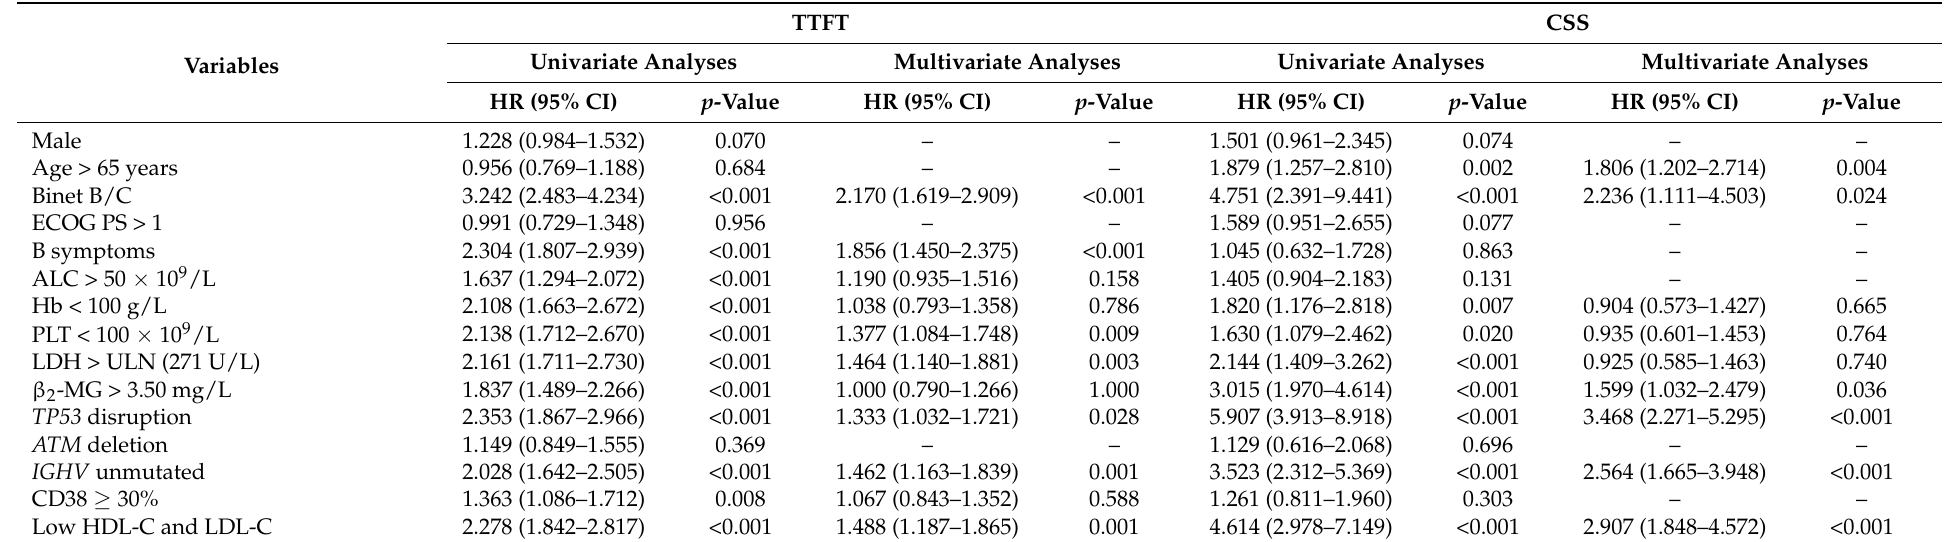
Table 2. Univariate and multivariate analyses of TTFT and CSS in the derivation cohort. TTFT CSS Univariate Analyses Multivariate Analyses Univariate Analyses Multivariate Variables